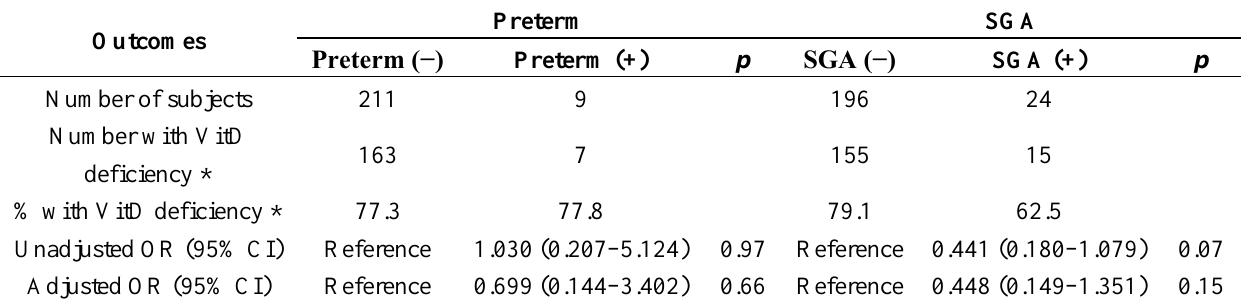
Table 5. Associations between vitamin D deficiency, preterm babies, and SGA